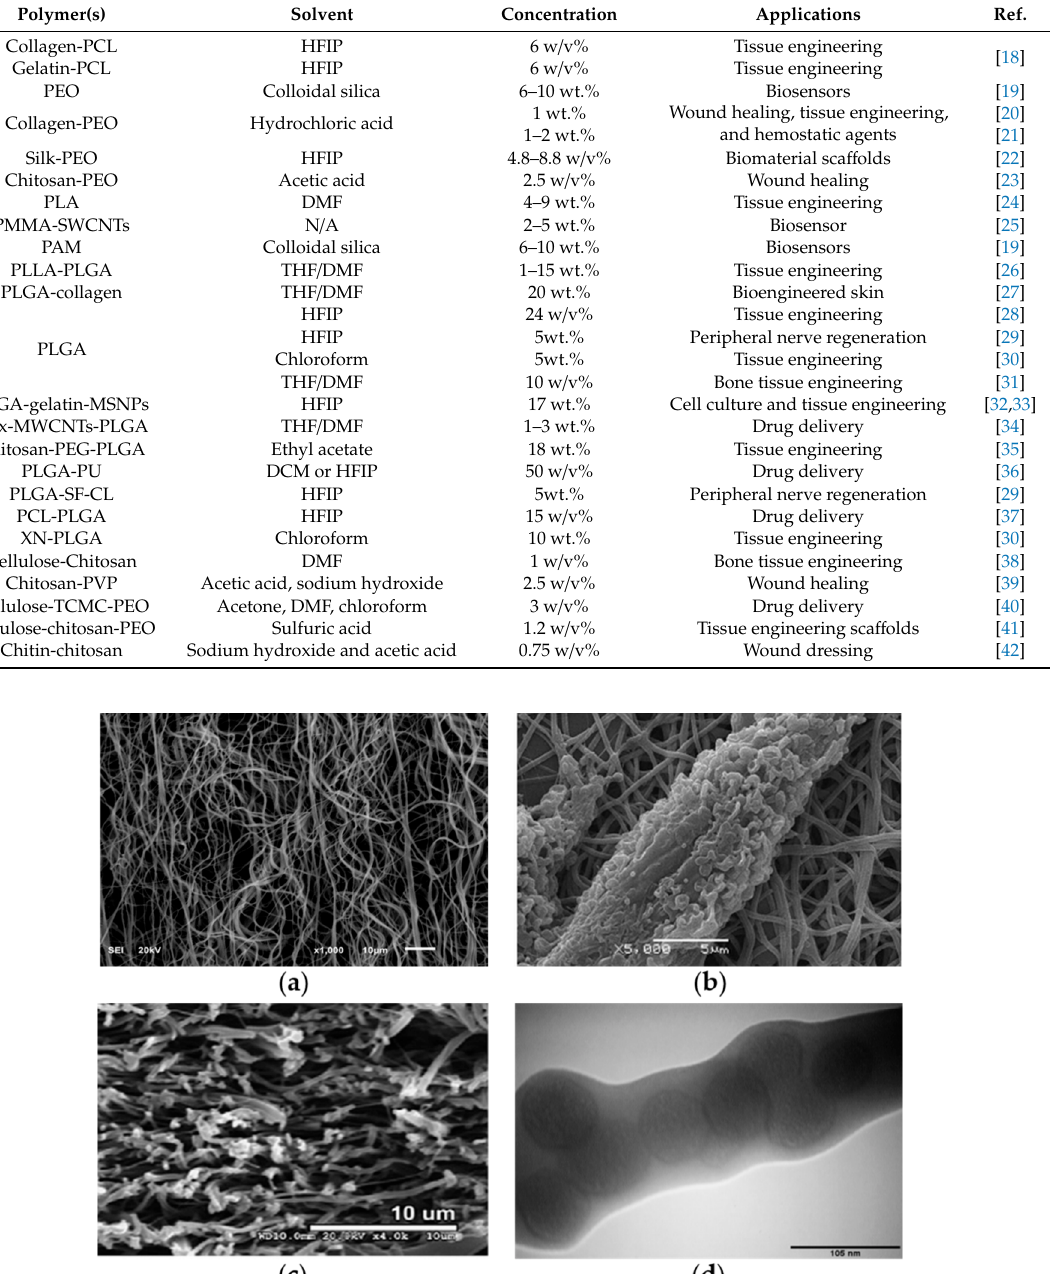
Table 1. Fibers from di ff erent polymeric biomaterials for biomedical applications.